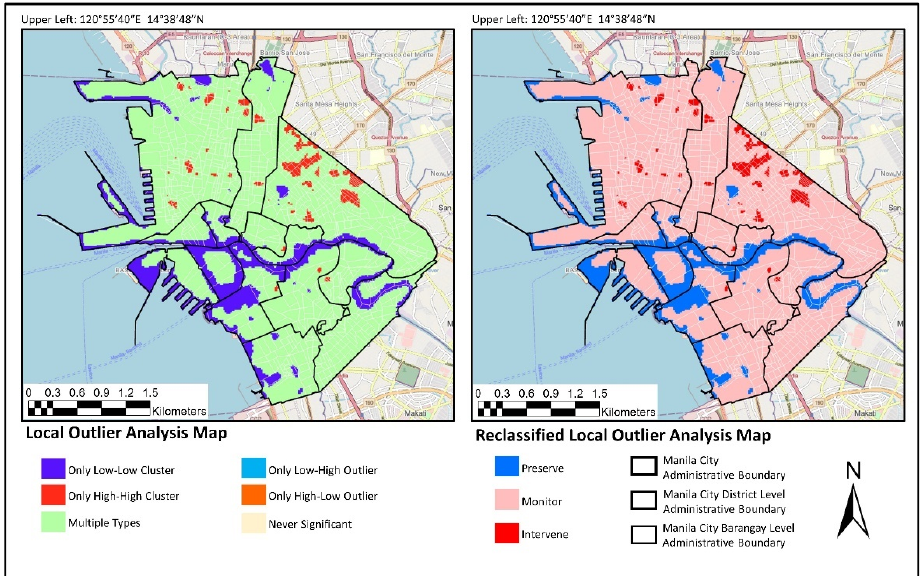
Figure 11. Local Outlier Analysis Map and the reclassified map with the corresponding new class.